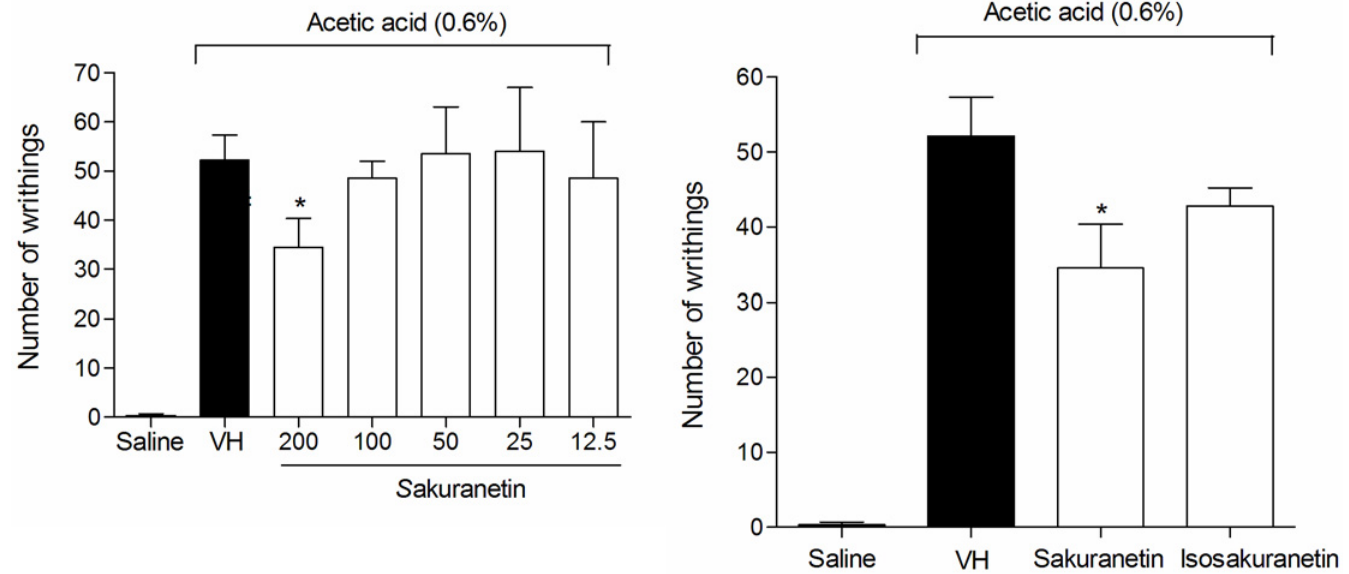
Fig 16. Effect of sakuranetin and synthetized isosakuranetin at a 200 mg/kg dose on acetic acid (0.6%)-induced writhing. Sakuranetin was tested at different doses (12.5 – 200 mg/kg) and compared to isosakuranetin. VH is the vehicle group (negative control). The results are presented as the mean ± S.D. (n = 8). Statistical significance was calculated by ANOVA followed by Bonferroni's test. * P < 0.05 compared to the vehicle-negative control treated group.